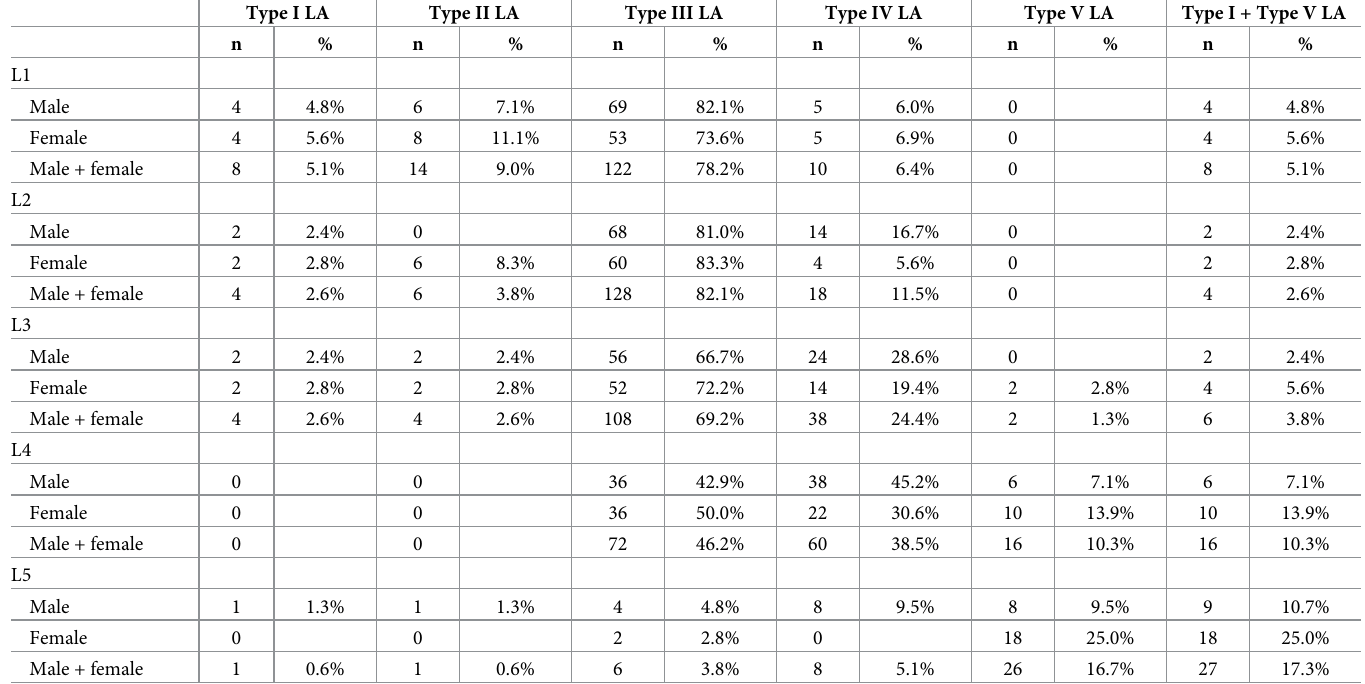
Table 2. The number of Type I-V LAs and Type I + Type V LAs in